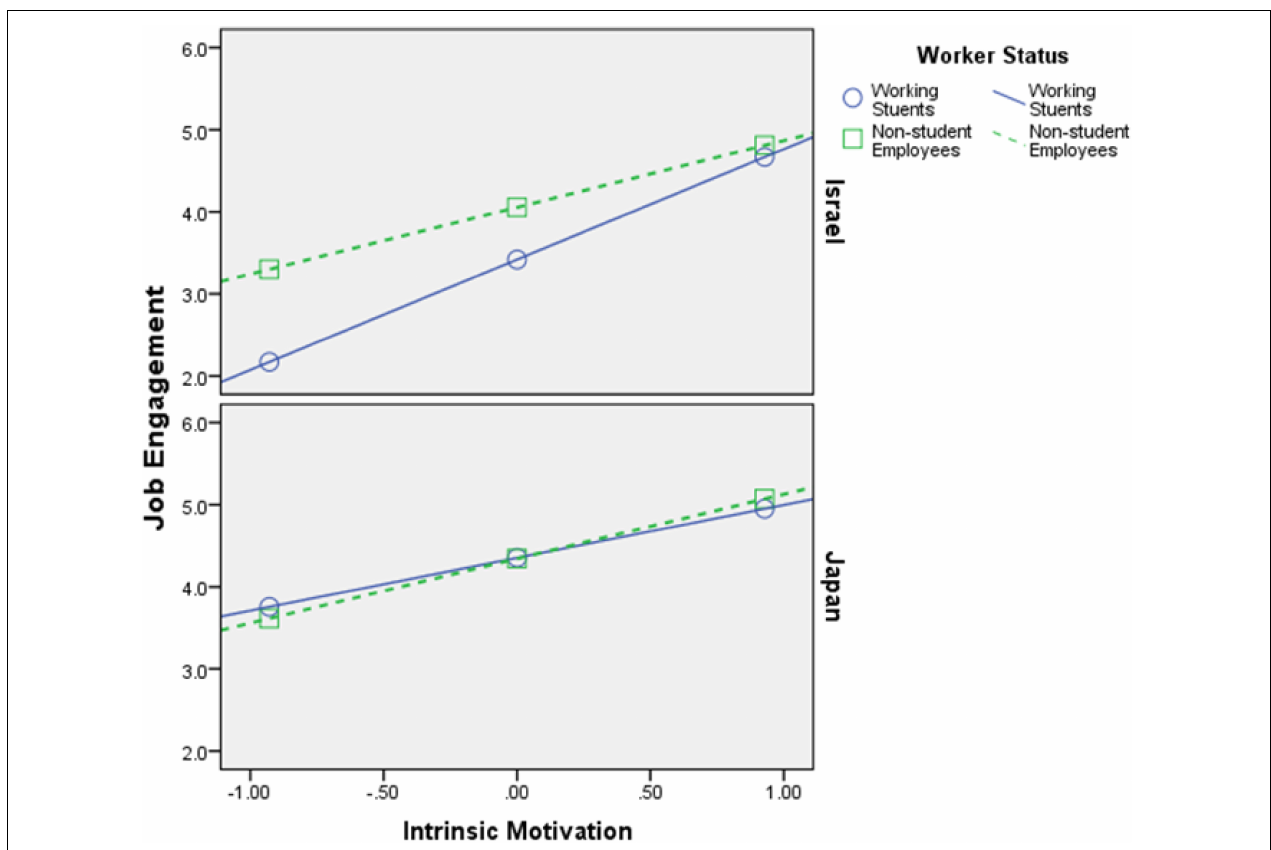
FIGURE 6 | Interaction effects of Intrinsic Motivation × Worker’s Status × Country in predicting job